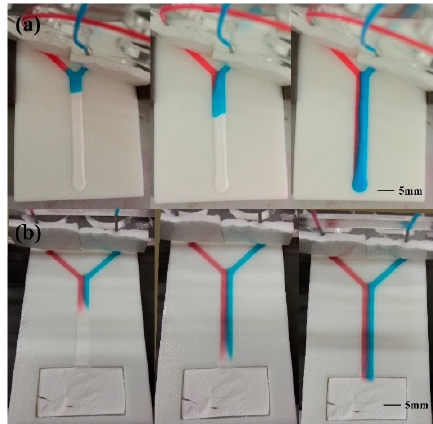
Figure 9. Time-lapse image of two different dyes diffusing in the fabricated Y device: ( a ) Microfluidic Y device with two different fluid path lengths; ( b ) Microfluidic Y device with the same path length.